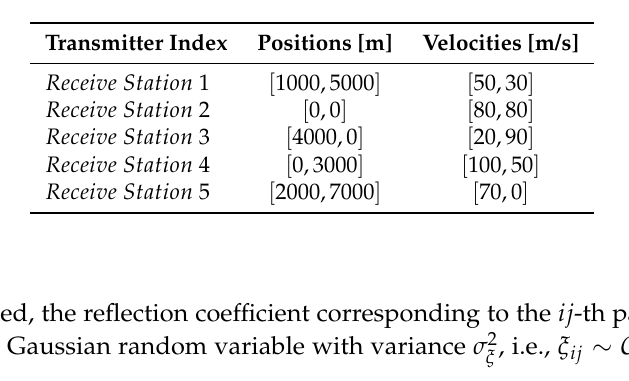
Table 2. Positions and Moving Parameters of the Receive